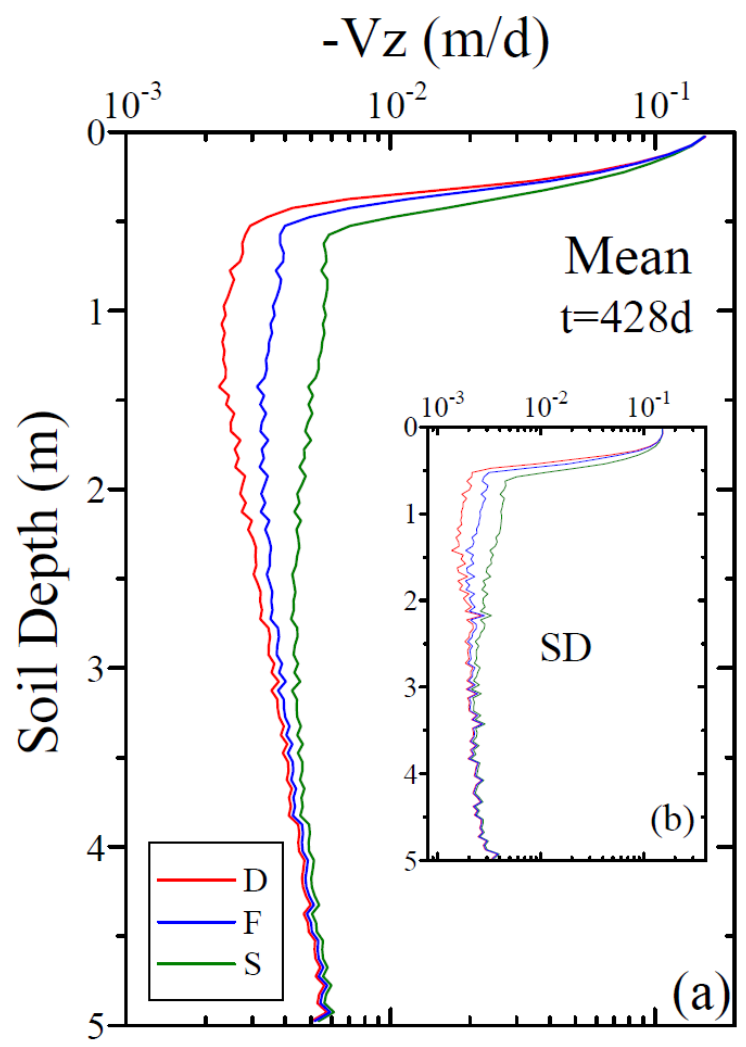
Figure 4. Profiles of the ( a ) horizontally averaged mean and ( b ) SD of the vertical component of the velocity vector for the different scenarios examined. Results are depicted for the irrigation season of the second year.